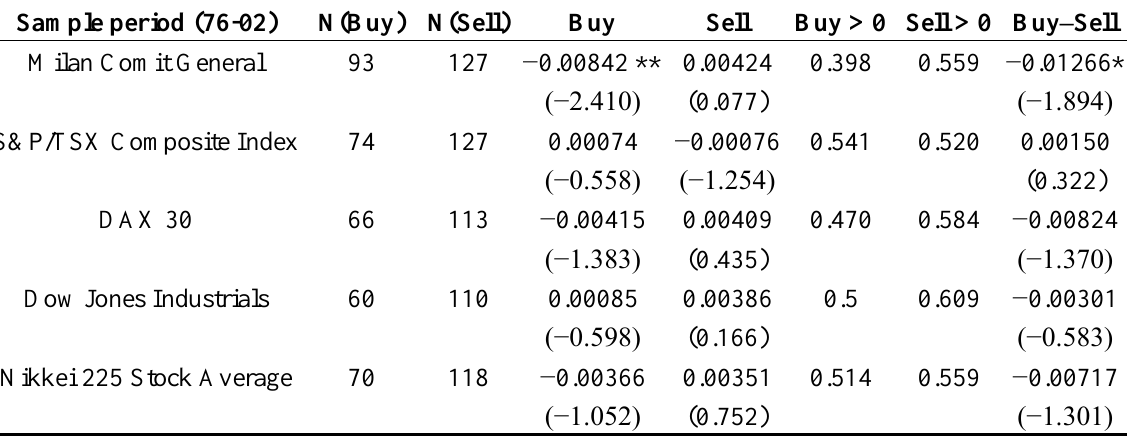
Table 3F. Average ten-day returns from RSI (21,